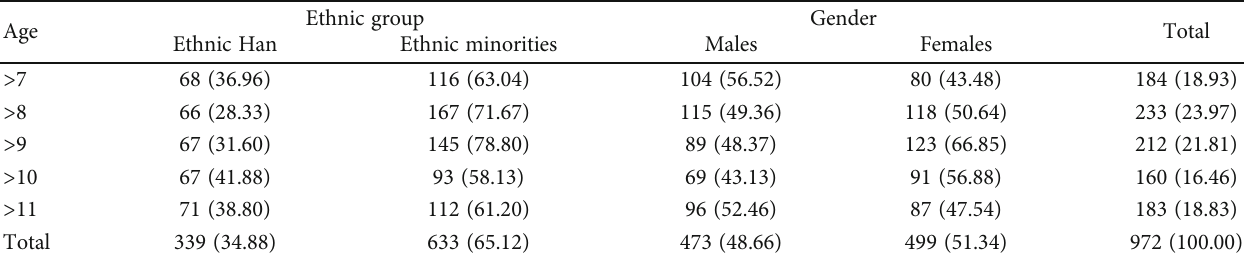
Table 1: General characteristics of study the